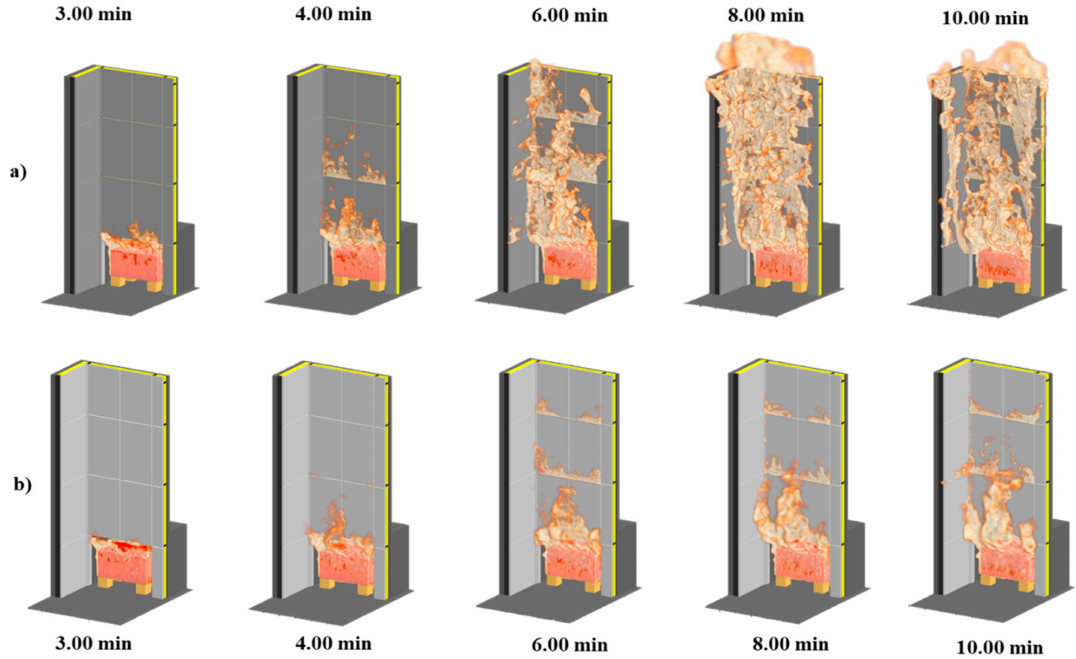
Figure 17. Fire spread of the cladding system ( a ) combustible cladding (S1) ( b ) non-combustible cladding